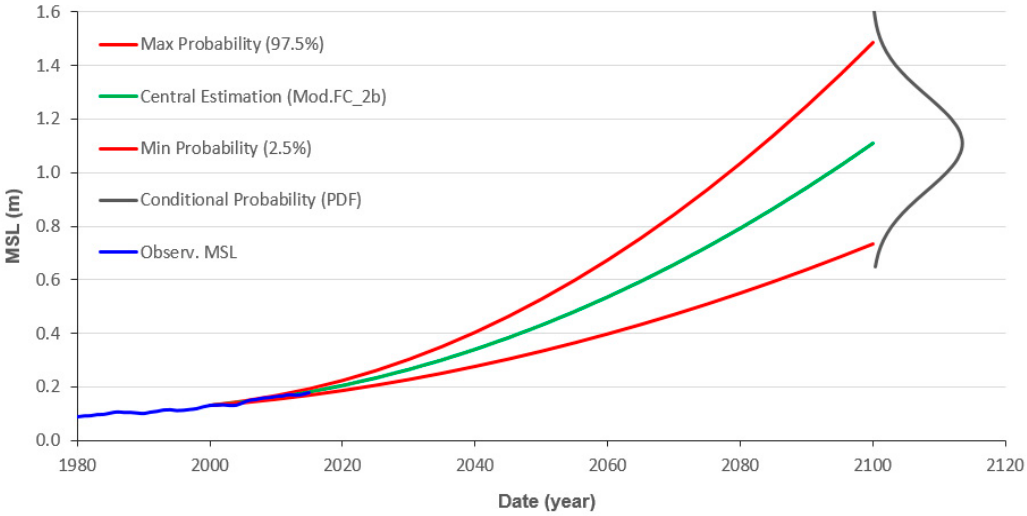
Figure 1. Model of the relative SLR projection, Mod.FC_2b (Model 2b of Faculdade de Ciências da Universidade de Lisboa (FCUL)), based on the analysis of the Cascais tide gauge data series, from 1992 to 2016 [5], overlapped with observed mean sea level (MSL) at Cascais TG.